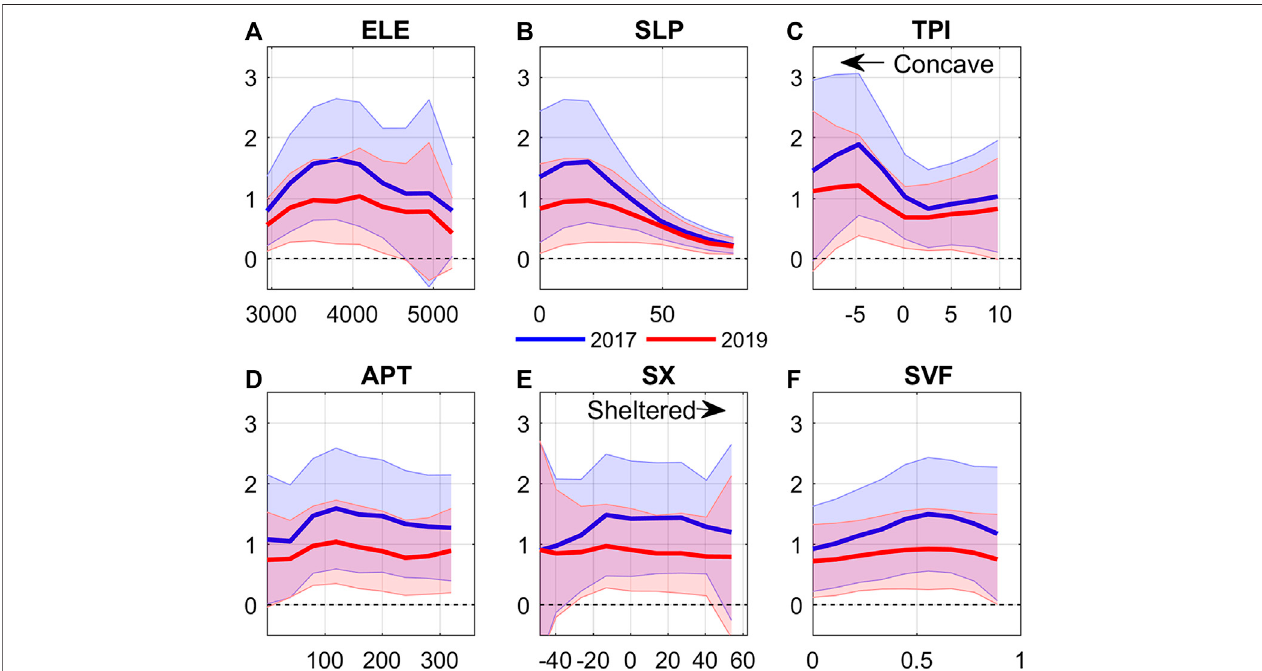
FIGURE 7 | The mean (solid line) and standard deviation (shaded bars) of snow depth in 10 equal intervals of the topographic indices of the catchment (see text). ELE, elevation (m a.s.l.), SLP, slope ( ° ), TPI, topographic position index ( − ), APT, aspect ( ° ), SX, exposure ( − ) and SVF, sky view factor ( − ). Blue and red lines indicate the results for 2017 and 2019, respectively.